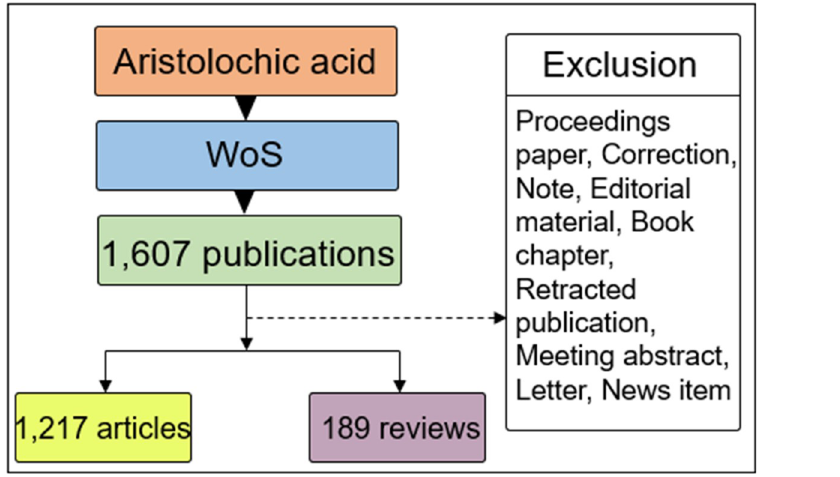
Fig 1. Retrieval strategy and number of